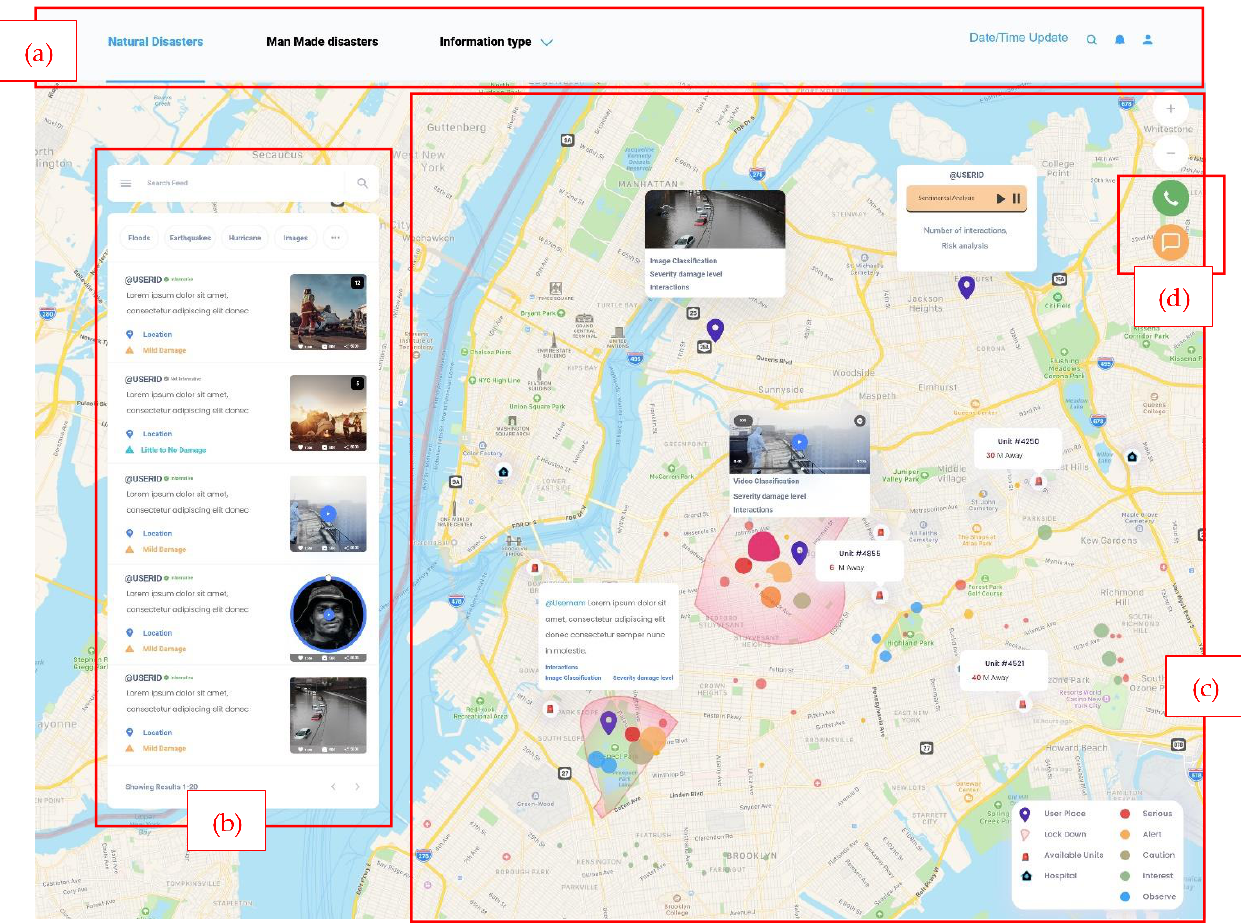
Figure 9. One-page flow visualization user interface of text, image, audio, and video disaster information. ( a ) the header and disaster types, ( b ) the live SNS feed is shown on the map, ( c ) user’s location on the map, and ( d ) call and message buttons.